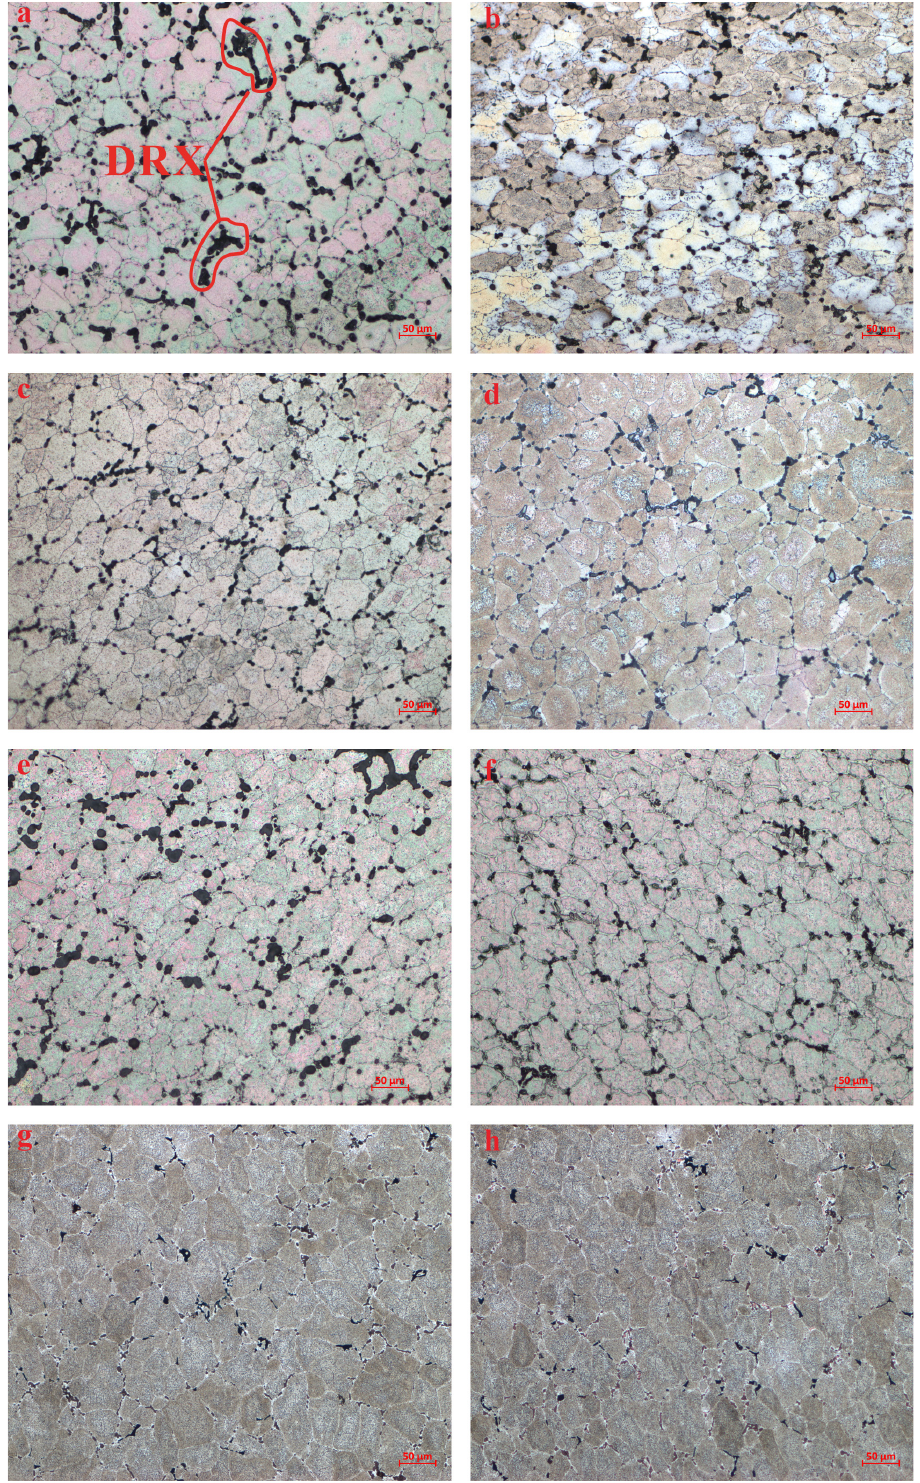
Figure 5. Gleeble specimen metallographic micrograph 1. ( a ) 360 °C—0.01; ( b ) 360 °C—0.1; ( c )